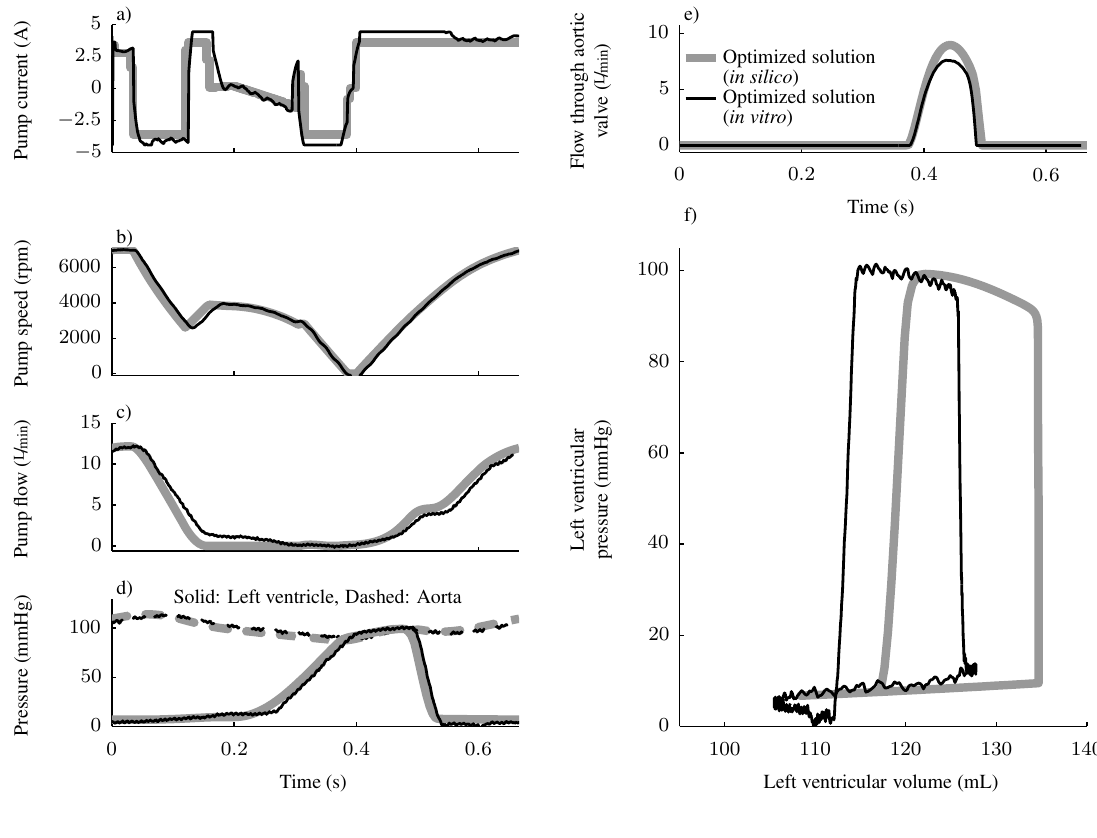
Figure 4. The optimal solution for maximizing the flow through the aortic valve ( ρ = 0 ), in silico and in vitro . Panels ( a )–( c ) show the current, the speed, and the flow rate of the pump. Panel ( d ) shows the left ventricular (solid) and the aortic (dashed) pressures. Panel ( e ) shows the flow through the aortic valve. Panel ( f ) shows the left ventricular pressure-volume